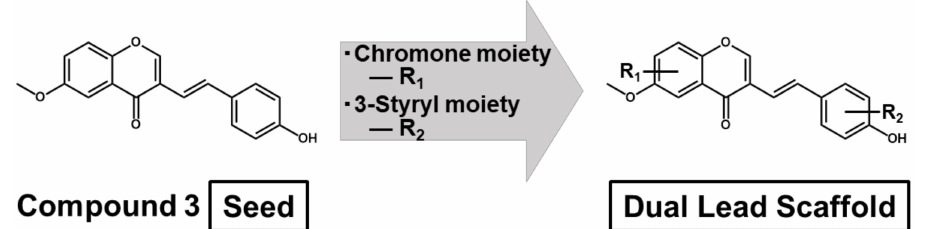
Figure 6. Designing a new lead scaffold for the development of novel dual pharmaceuticals possess- ing anti-cancer and anti-inflammatory activities. The two sections of the 3-styrylchromone molecule, the heterocyclic chromone, and 3-styryl benzene ring moieties are subjected to structure optimization studies for functional groups of R1 and R2,